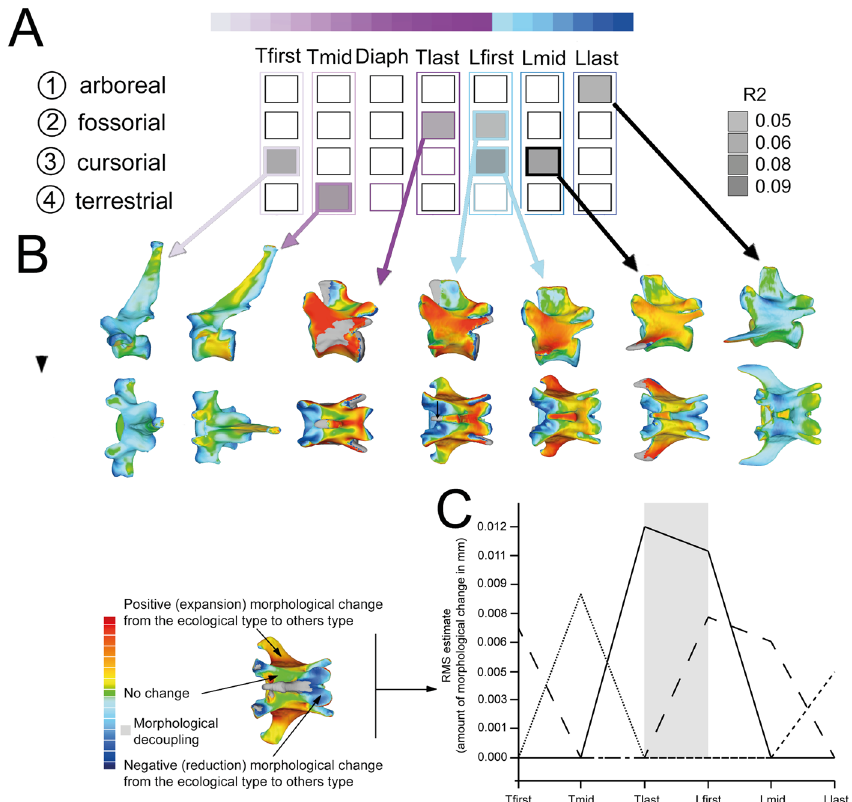
Fig. 6 Ecomorphological analysis of presacral vertebra shapes excluding aquatic taxa and selecting vertebrae by position. A Vertebrae signi fi cantly associated with a given ecological category (1, arboreal; 2, fossorial; 3, cursorial; 4, terrestrial). The signi fi cance of R 2 (grey-colour squares) for each vertebra is indicated by frame thickness; thick frames p values <0.01; thin frames p values <0.05; absence of frame indicates p values >0.05. B Three- dimensional models obtained from phylogenetic Procrustes ANOVAs showing for each for each signi fi cant association of “ vertebra-ecology ” the morphological deviation from the corresponding shape for a given ecology (red) to the vertebral shape of the rest of the sample (blue). C Quanti fi cation of the morphological deviation obtained from the three-dimensional models represented in ( B ) showing the vertebrae that experience most of the changes in shape. Dotted line represents morphological deviations for arboreality, dashed line for cursoriality, and bold line for